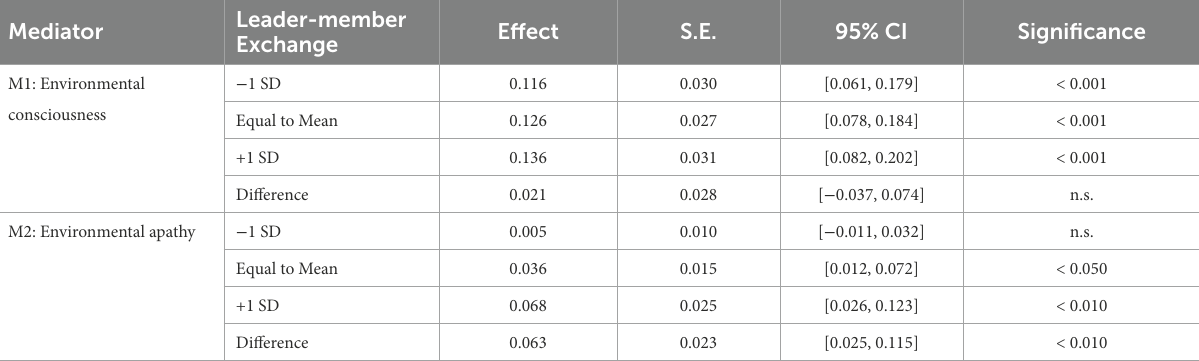
TABLE 6 Regression results for moderated mediating